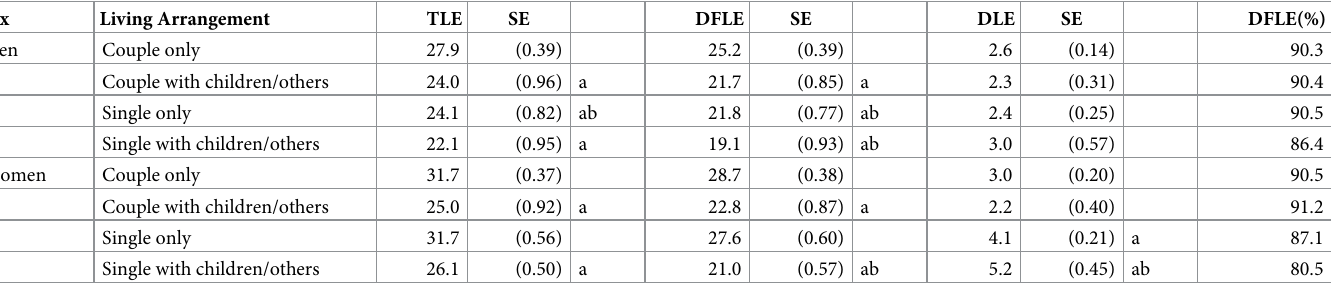
Table 8. Total, disability-free, and disabled life expectancy by gender and living arrangement for non-Hispanic whites at age 50 among those who never change their living arrangement during analysis period: Status-based estimates with initial health state being disability-free. Sex Living Arrangement